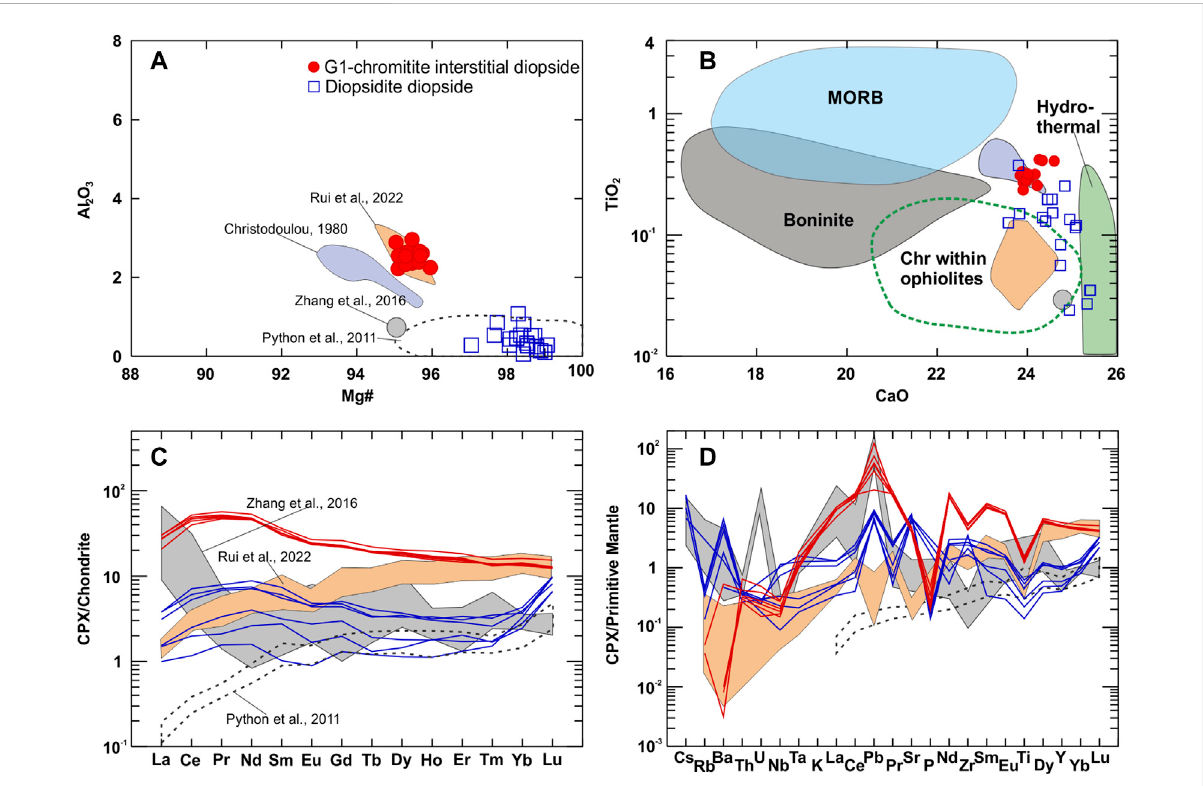
FIGURE 6 Diopside microprobe analyses per lithotype: (A) Al 2 O 3 vs Mg# plot; (B) TiO 2 vs CaO plot. The dark-blue fi eld consist of diopside inclusions in G1 chromitites, reported by Christodoulou (1980); the dotted line represents diopside analyses from Oman diopsidites (Python et al., 2011), orange fi eld represents analyses of chromitite hosted diopside of Moa-Baracoa (Rui et al., 2022) and gray fi eld represents analyses of chromitite hosted diopside of Kop Ophiolite (Zhang et al., 2016). Fields of MORB (blue), boninite (grey), hydrothermal (green) and clinopyroxene associated with chromiteinophioliticrocks(dottedgreenline,Chrwithinophiolites)arefromSuetal.(2021)andreferencestherein.ChondriteandPrimitivemantle- normalized (PM N ) LA-ICP-MS analyses of clinopyroxenes ’ (CPX) trace elements plots (C, D) after Sun and McDonough